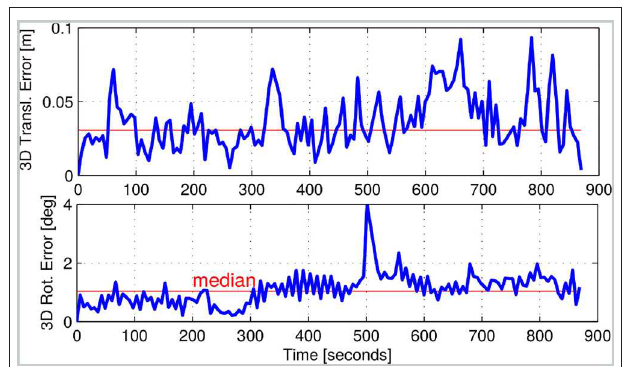
FIGURE 11 | Estimated error of the state estimator used in Experiment 6a. The experiment involved the robot crawling for a total of